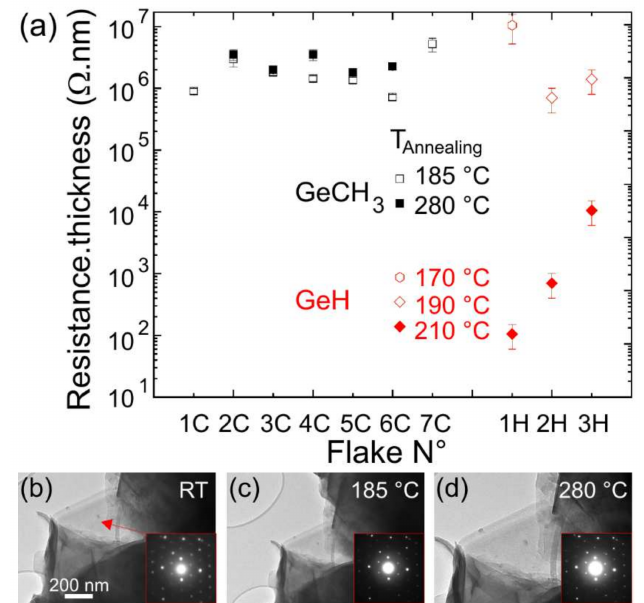
Figure 5. ( a ) Comparison of the product of the four-point resistances to the crystallite thickness for GeCH 3 (C) microcrystallites and H-passivated (H) flakes, measured as a function of the annealing temperature. The spacing between the electrodes or the tips varies in a range extending from 0.5 to 3.0 µ m. The data for the H-passivated flakes were deduced from the experimental results published in Refs. [9,18]. ( b – d ) TEM images and SAED patterns of the thin edge of a microcrystallite collected at room temperature (RT), 185 ◦ C and 280 ◦ C,